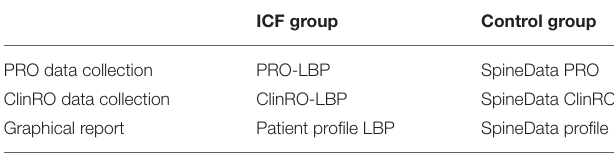
TABLE 1 | Collection and presentation of data in the two